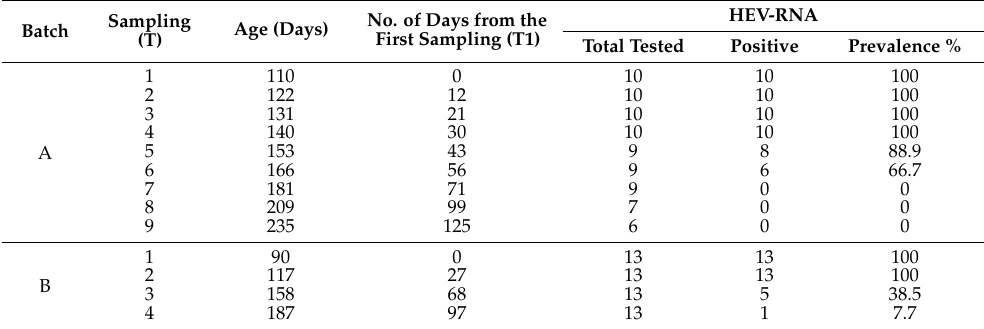
Table 1. Details of samples analyzed including age of animals, interval of time (days) of samplings and results of HEV-RNA detection are